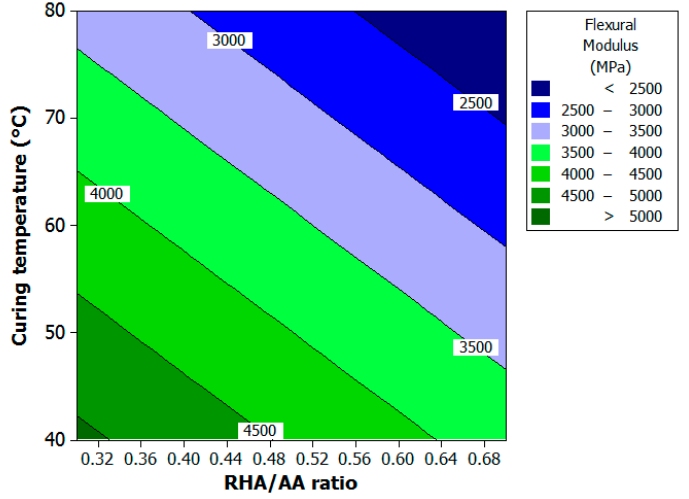
Figure 6. Contour plot of curing temperature vs. RHA/AA ratio.